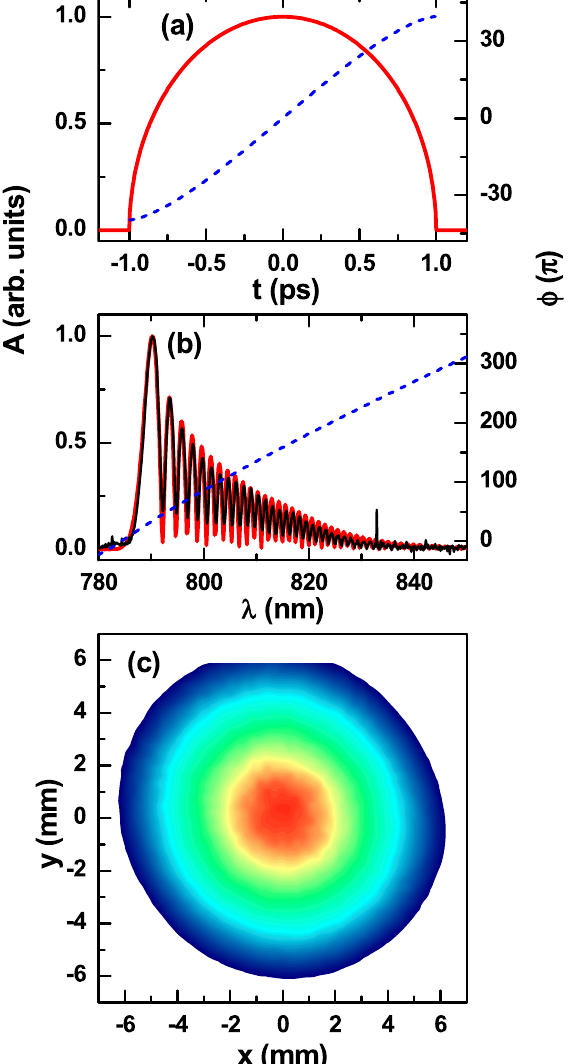
FIG. 8. (Color) Laser pulse amplitude A (bold solid lines) and phase (cid:5) (dashed lines) calculated from Eqs. (5) and (6) for (cid:6) ¼ (cid:7) ¼ 1 = 2 in the time (a) and frequency (b) domains, and the measured spectrum amplitude [thin solid line in (b)]. The trans- verse profile of the laser pulse after the spatial filter and before the ZnSe lens is shown in (c) with a slight